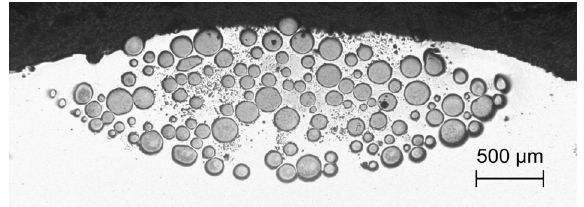
Figure 4. Cross-section of composite trace in Al6061alloy with WC powder particles; experimental conditions: E 0 = 82 J/mm 2 , ν sc = 10 mm/s, m p = 30 g/min.